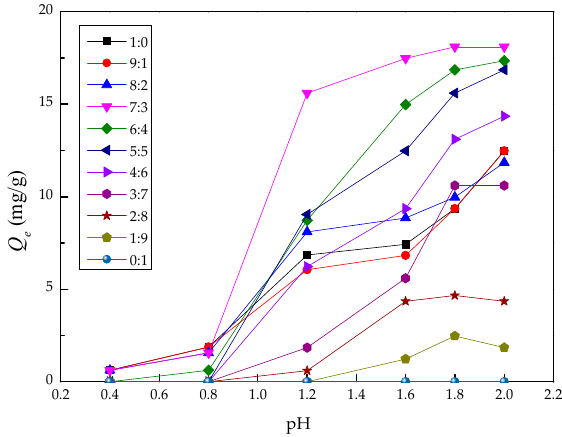
Figure 2. Adsorption capacity of different SIRs for V(IV) at different pH (concentration of the mixed extractant is 1 mol/L, adsorption time 16 h).